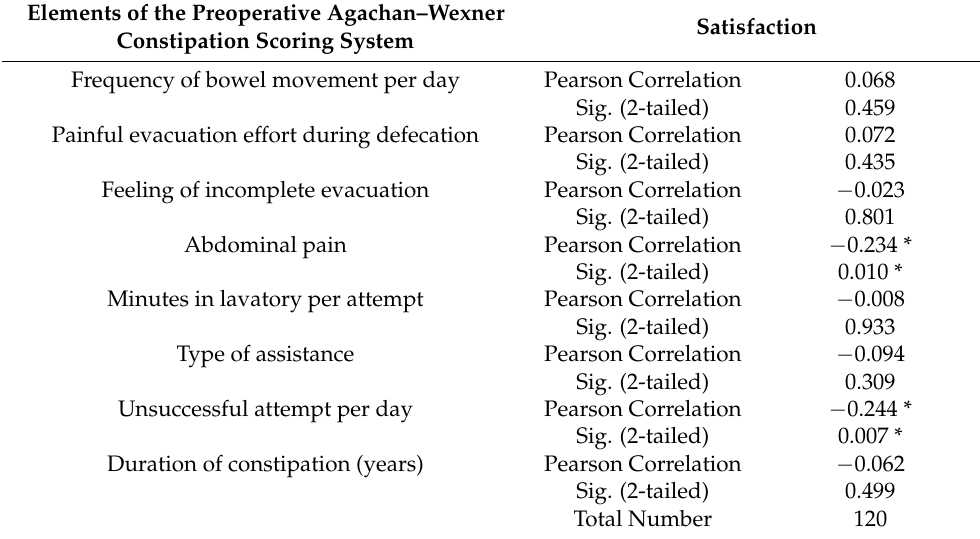
Table 4. Correlation between patient’s satisfaction and the different elements of pre-operative constipation scores (Agachan–Wexner Constipation Scoring System). Elements of the Preoperative Agachan–Wexner Constipation Scoring